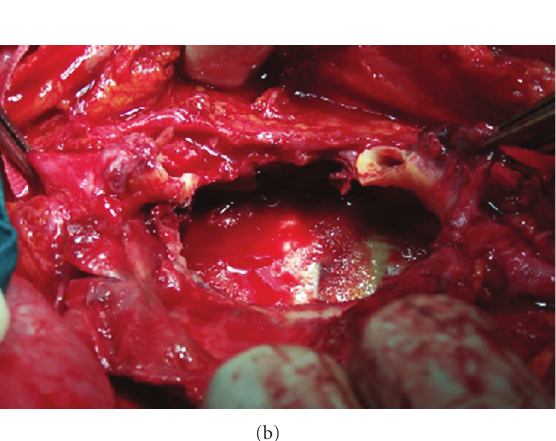
Figure 2: (a) Pseudoaneurysm after opening the aneurysmal sac and showing the neck of the pseudoaneurysm at the abdominal aorta. (b) Huge pseudoaneurysm after evacuating the thrombus and resecting the diseased part of the abdominal